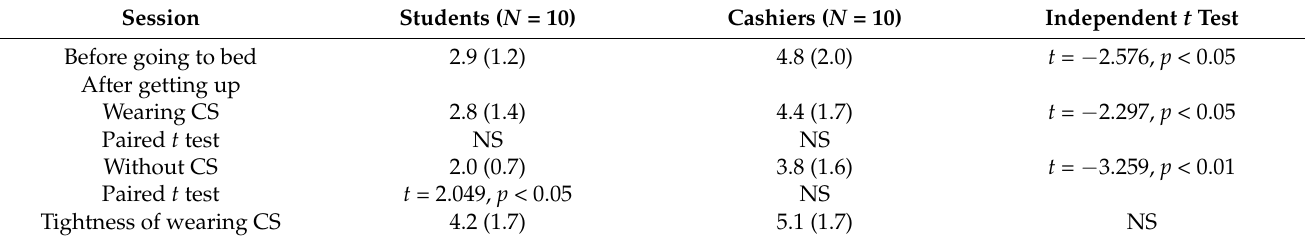
Table 3. Results of the discomfort (or tightness) scores and paired and independent t